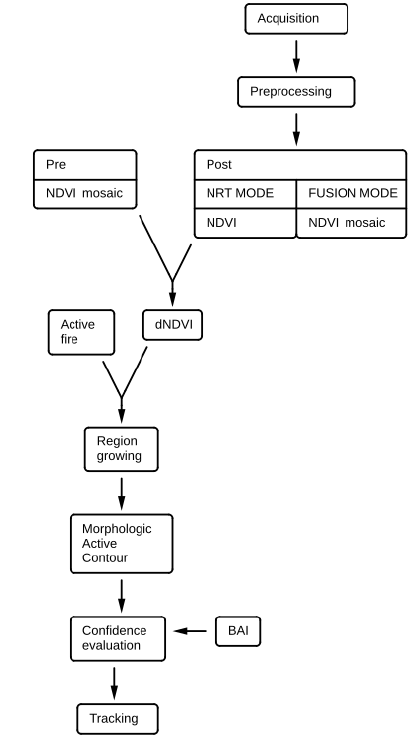
Figure 1. Diagram of the operating chain, showing the steps which are performed in order to derive burnt area